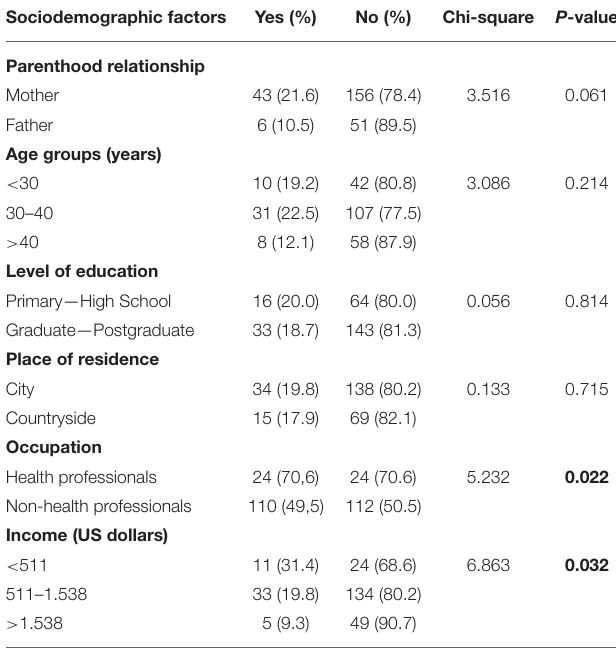
TABLE 6 | Awareness of parents about the conditions requiring urgent dental